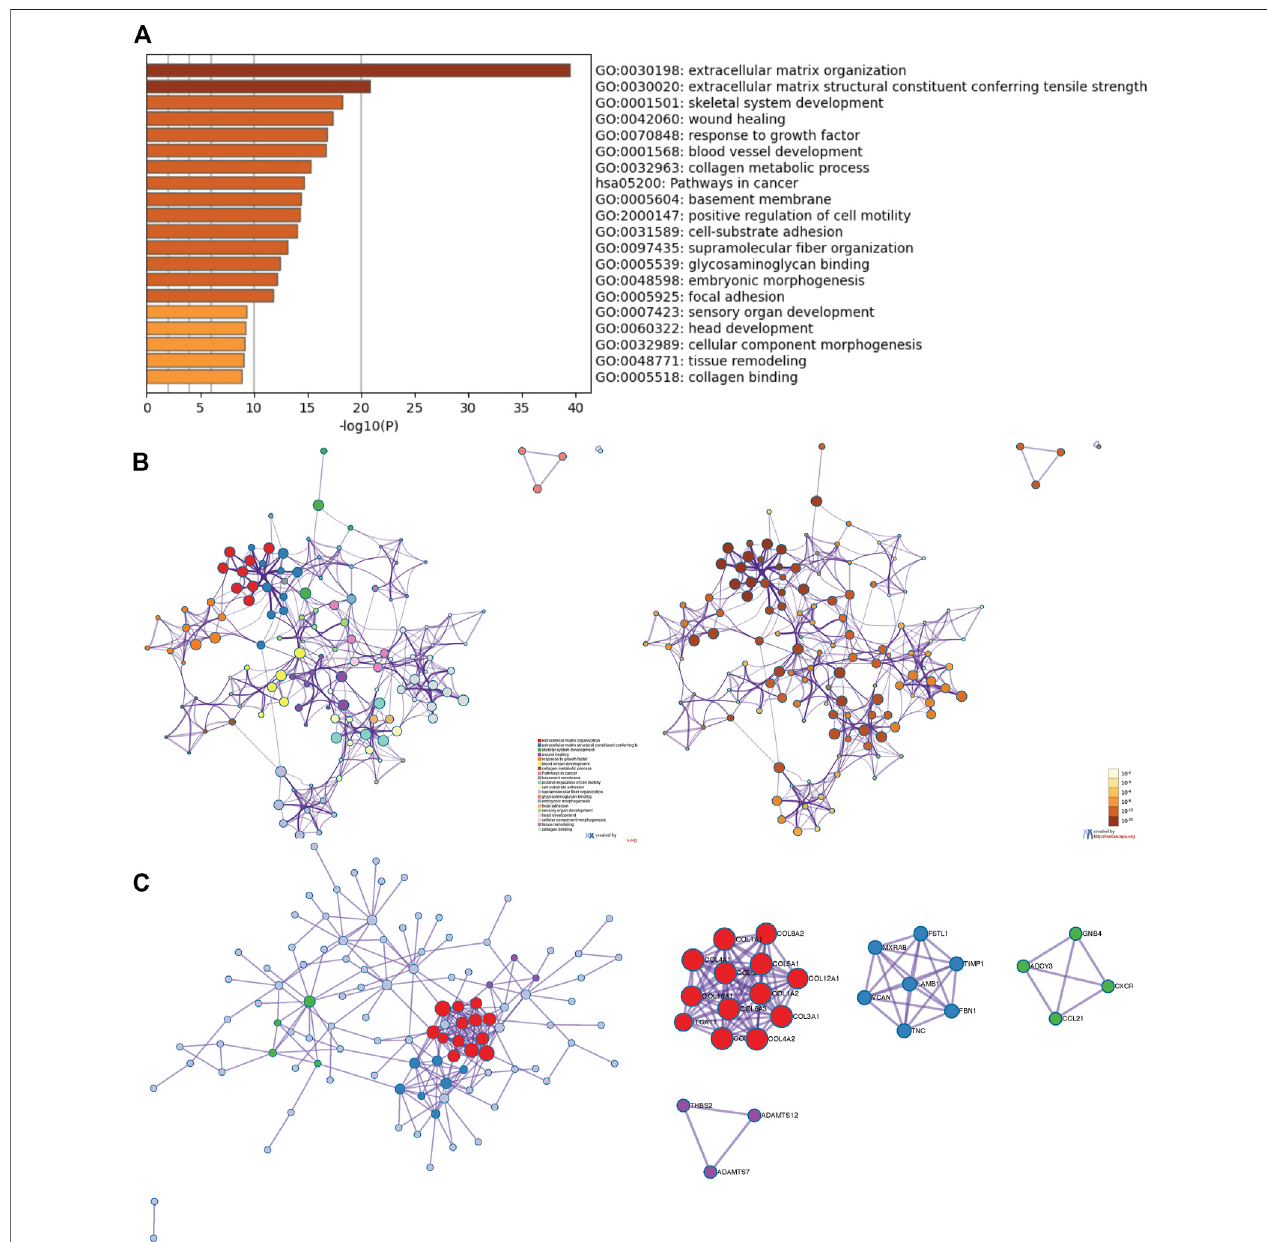
FIGURE8| Theenrichmentanalysisandvisualizedprotein-proteininteraction(PPI)enrichmentanalysisofco-expressedgenesofLOXs(Metascape). (A) Heatmap of enriched terms regarding Gene Ontology analysis colored by p -values. (B) An interactive network of the top 20 enrichment terms. (C) PPI network and densely connected network components are identi fi ed by the Molecular Complex Detection